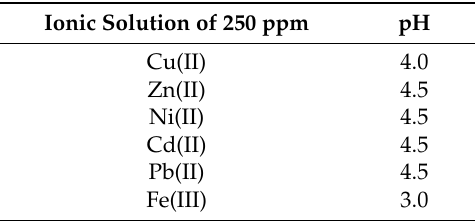
Table 2. The pH values of prepared ionic solutions for colorimetric assays.